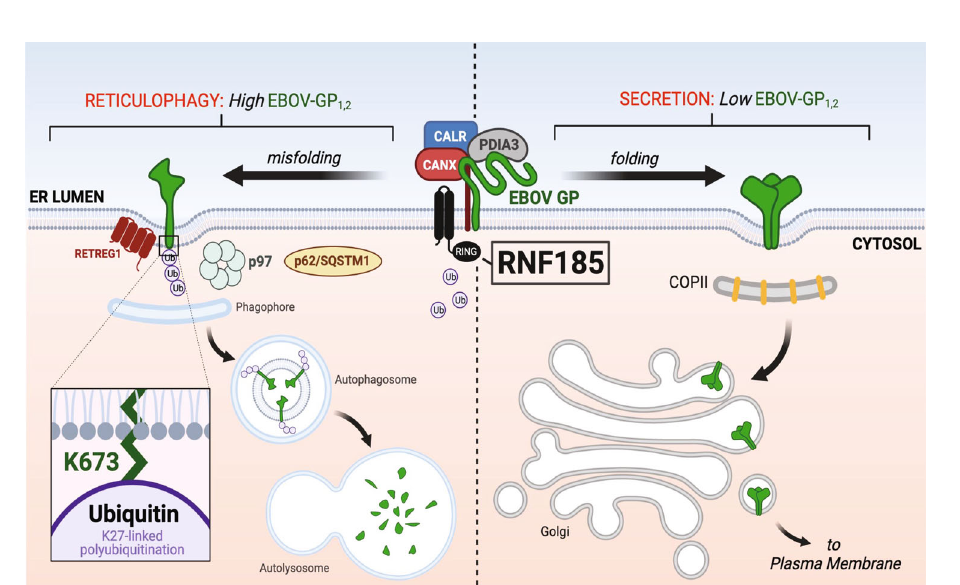
Fig. 10 | A model of how EBOV-GP 1,2 expression is regulated in the ER via reticulorphagy. When GP 1,2 levels are low in the ER, CANX-CALR cycle promotes GP 1,2 folding. Properly folded GP 1,2 is released from the ER to the Golgi via COPII vesiclesandsecretedtotheplasmamembrane.However,whenGP 1,2 levelsbecome highintheER,thesameCANX-CALRcyclestartstotriggerGP 1,2 misfolding.RNF185 polyubiquitinates aberrant GP 1,2 on K673 in the cytoplasmic tail via